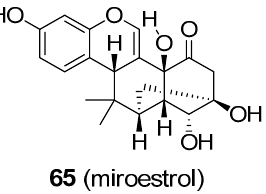
Figure 15. Molecular structure of miroestrol form Pueraria mirifica (Fabaceae).